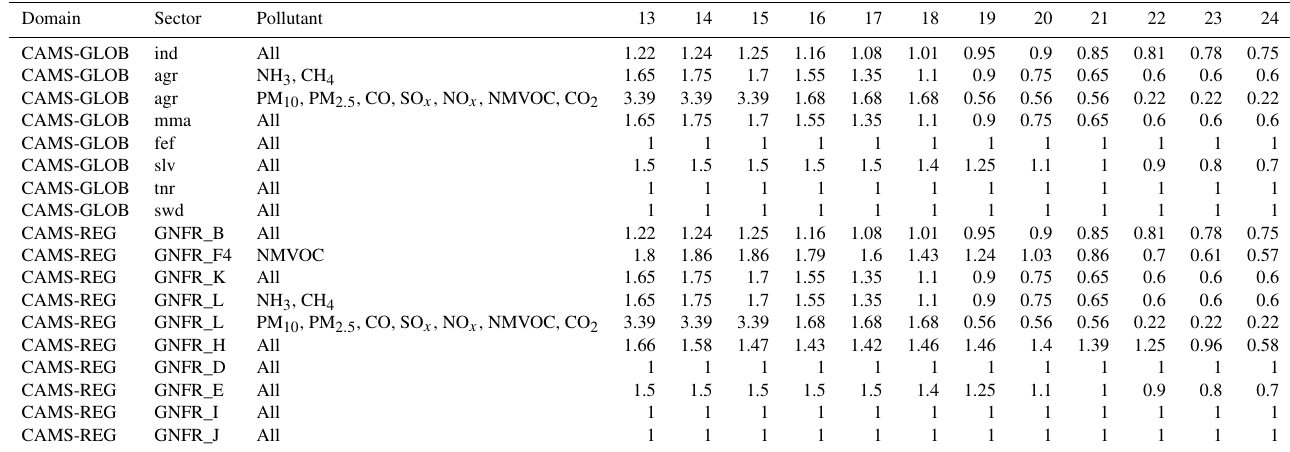
Table A4. Fixed hourly temporal profiles per domain, sector and pollutant (part 2: 12:00–13:00 to 23:00–00:00). The definition of the sectors can be found in Tables 2 and